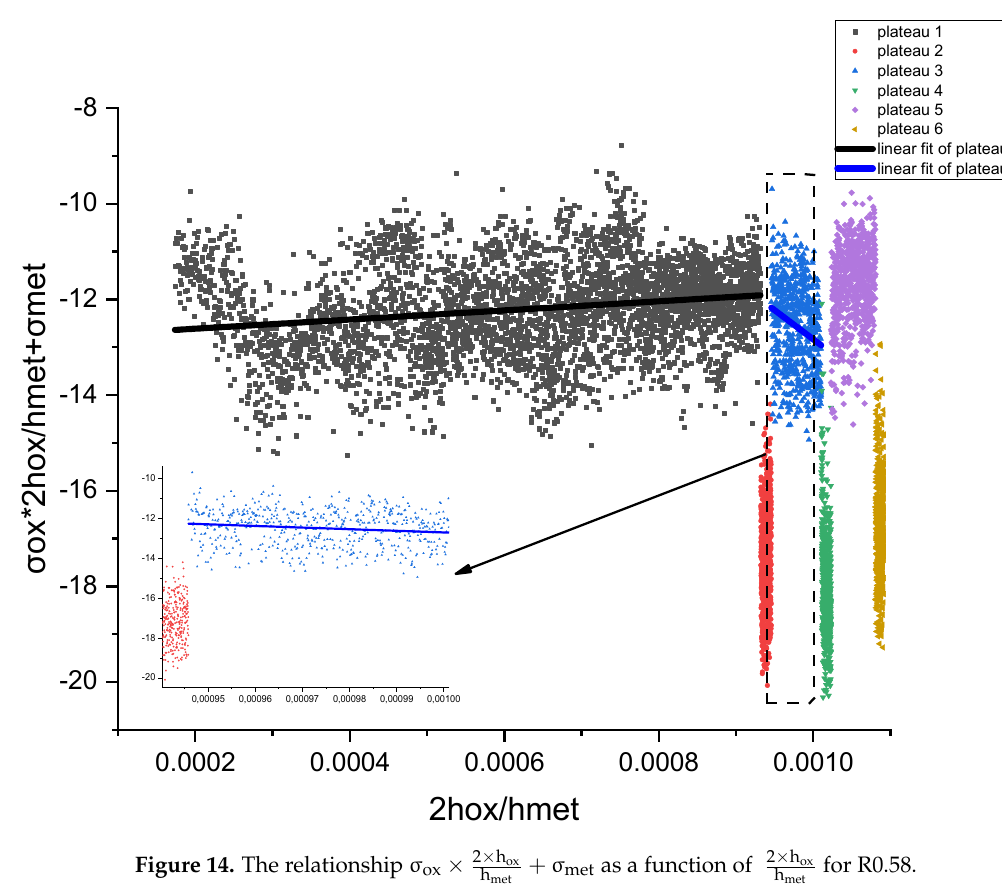
for h met ×  for R0.58.